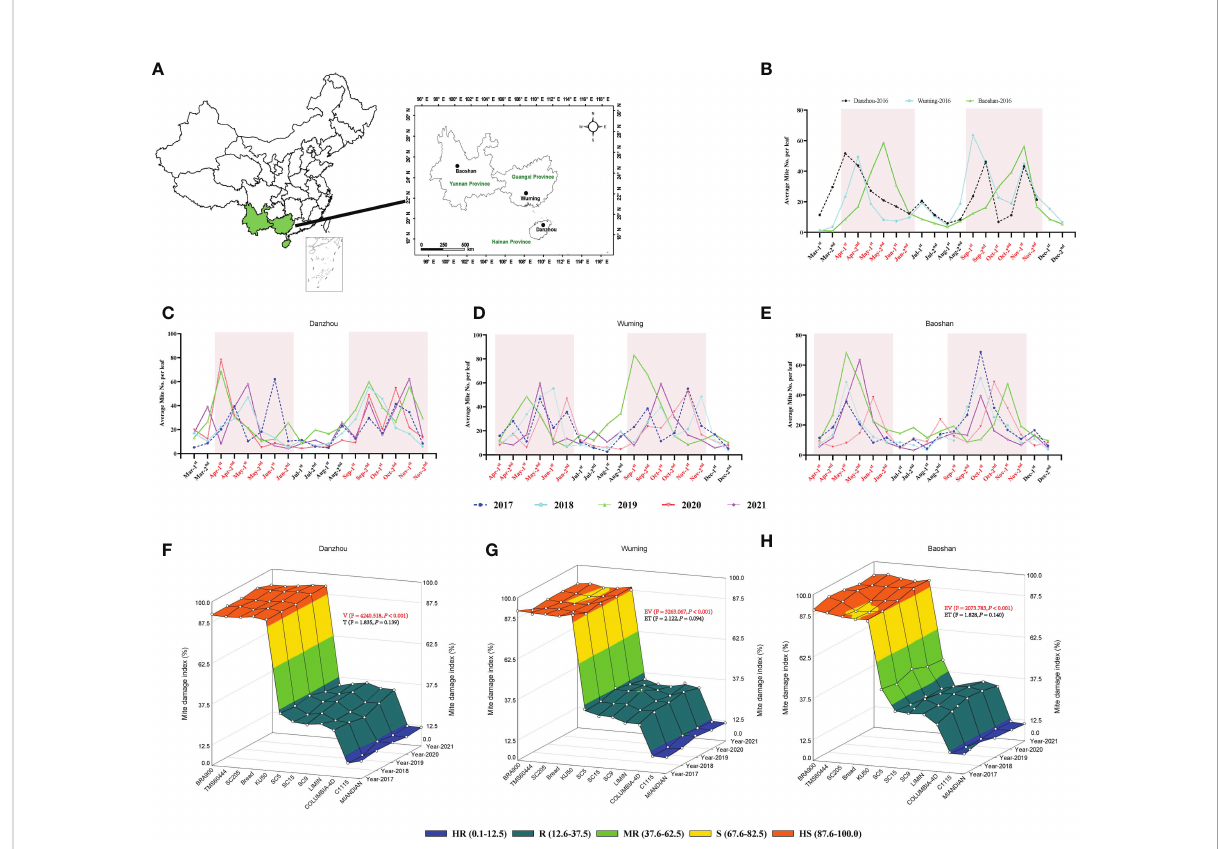
FIGURE 4 Five years of fi eld validation of cassava varieties resistant to two-spotted spider mite (TSSM). (A) Geographic information of the three different sites (Danzhou, Wuming, and Baoshan) for fi eld validation in China. (B) Population dynamic of TSSM at Danzhou, Wuming, and Baoshan in the year of 2016. (C – E) Population dynamic of TSSM at Danzhou (C) , Wuming (D) , and Baoshan (E) from 2017 to 2021. The shaded boxes indicate the TSSM population peak time frame of the three sites. (F – H) Field validation results of TSSM resistance of 12 cassava varieties at Danzhou (F) , Wuming (G) , and Baoshan (H) . The different color zones indicated the different resistant levels. The generalized linear mixed model was used to analyze the multiple effects such as experimental varieties and experiment time on the mite damage index, the F - and P -values were indicated within panels (F – H) . Furthermore, the P -values that represent statistical difference were marked in red (signi fi cance level =